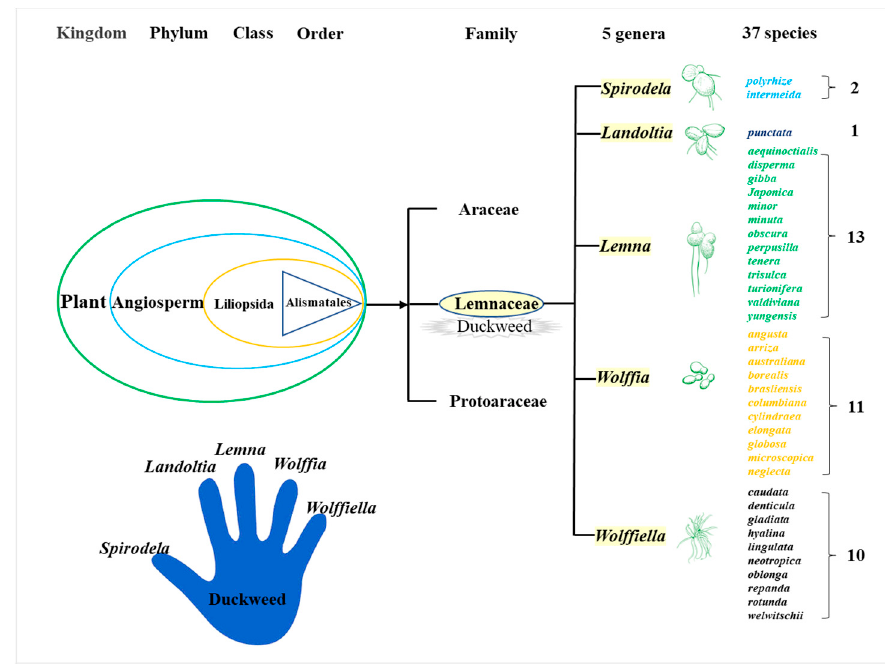
Figure 1. Lemnaceae family [22,26]. Drawn from representative plates in Reference [21].